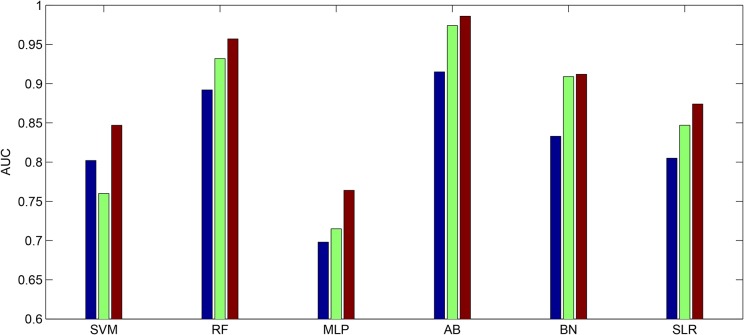
AUC values of the EMD based features derived from channel 1, 2 and 3 of TPEHG dataset for the six classifiers.The blue bar denotes the features extracted from channel 1. The green bar denotes the features extracted from channel 2. The red bar denotes the features extracted from channel 3. (SVM: Support Vector Machine. RF: Random Forests. MLP: Multilayer Perception. AB: AdaBoost. BN: Bayesian Network. SLR: Simple Logistic Regression).